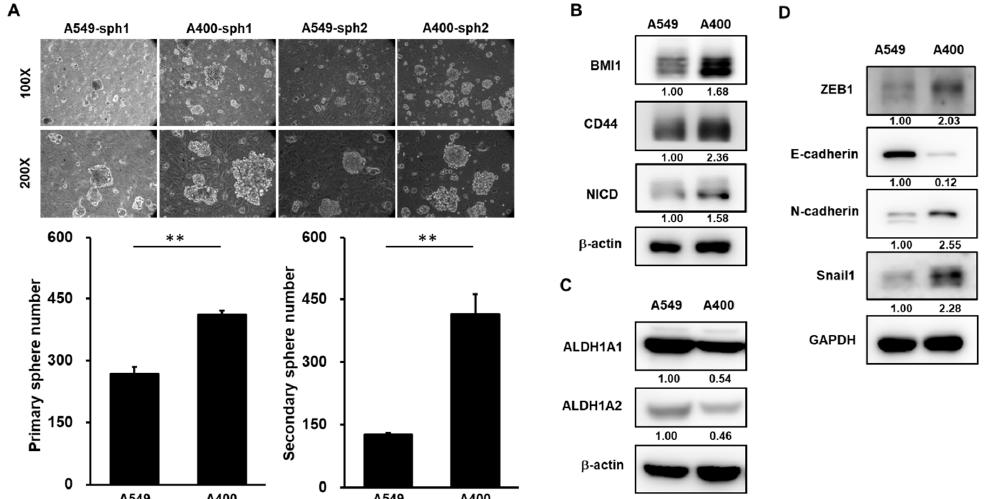
Figure 1. Cancer stem cell (CSC) activity and epithelial-to-mesenchymal transition (EMT) signature is upregulated in pemetrexed-resistant non-small-cell lung cancer (NSCLC) cells. ( A ) The CSC activity in A549 cells or their derived pemetrexed-resistant A400 cells was determined by tumorsphere cultivation. Primary tumorspheres (sph1) were counted at Day 21 by an inverted light microscopy after cultivation. Single cells of primary tumorspheres were obtained by HyQTase dissociation and used for secondary tumorsphere formation (sph2). **, p < 0.01. ( B , C ) The total proteins were collected from A549 or A400 cells and western blotting was performed to determine the expression of cancer stemness factors ( B ), aldehyde dehydrogenase (ALDH) isoforms ( C ), or EMT-related proteins ( D ). All the experiments were done two times and data from one experiment were